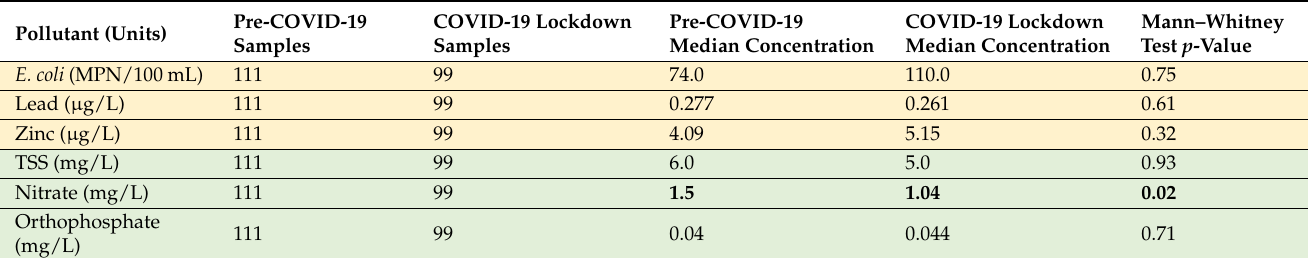
Figure 3. Sample distribution across COVID-19 periods for E. Coli , lead, zinc, nitrate, orthophosphate, and TSS from 21 eligible stations. Table 2. Mean concentrations and Mann–Whitney p -values for samples originating from 21 eligible stations during the COVID-19 period. Pollutants from anthropogenic sources are shaded yellow, while pollutants from more natural sources are shaded green. Bolded entries signify statistical significance ( p <